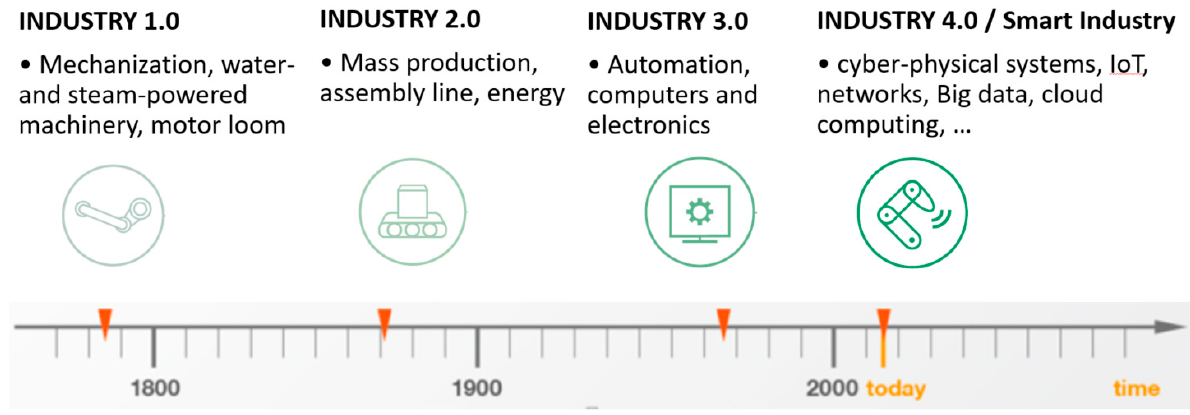
Figure 2. Fundamental trends of the industrial revolution. Source: own contribution based on [44,45]. The Fourth Industrial Revolution is the next stage of socio-economic